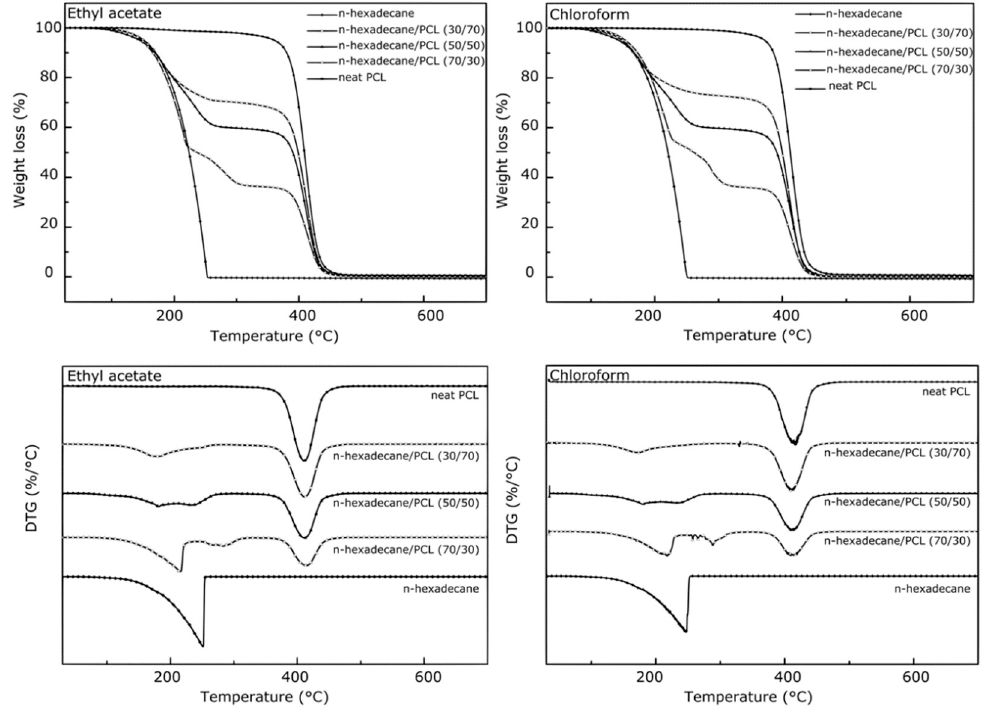
Figure 5. TG and DTG curves of n -hexadecane, neat PCL and the microencapsulated n -hexadecane.